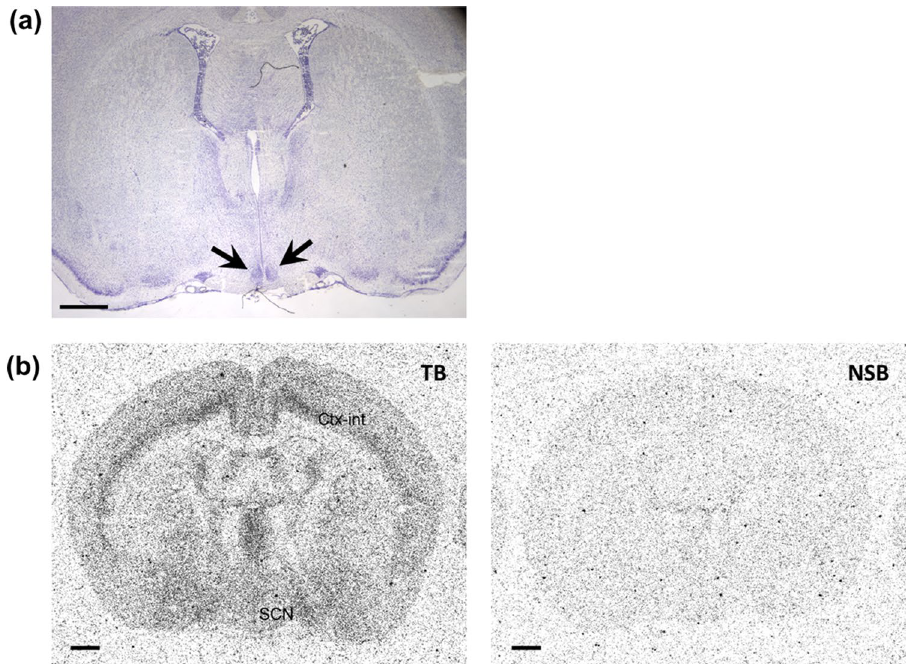
Figure 4. Distribution of [ 3 H]-EMPA binding sites in the suprachiasmatic nucleus (SCN) of the hypothalamus in rat brain sections. ( a ) A representative image of Nissl-stained coronal section from a rat brain is shown. Arrow indicates the SCN. ( b ) Representative images of the corresponding autoradiograms evaluating [ 3 H]- EMPA binding in the SCN and internal layer of cortex (Ctx-int) are shown. Non-specific binding (NSB) was analyzed in the presence of 1 µM JNJ-10397049. All the rat brain samples were collected at approximately the same time (ZT 2 ‒ 3). Scale bar represents 1 mm. TB total